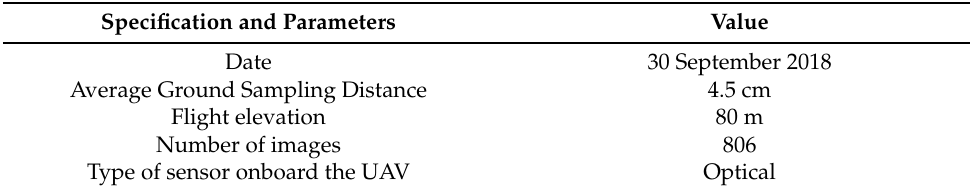
Table 1. Specifications of the UAV and flight